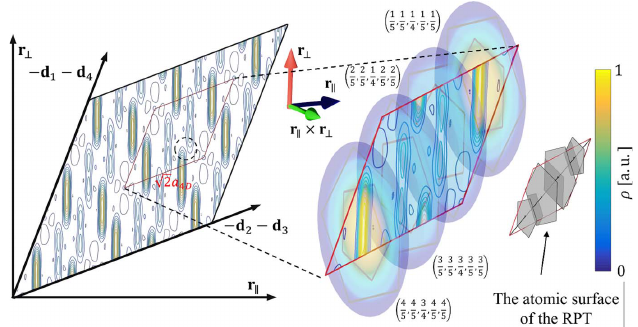
Figure 2 2D section through the 4D electron density map calculated on the basis of the 737 phased diffraction peaks. Two atomic layers of the physical space are superposed here. Four atomic surfaces centered along the [1111] direction are identified. They divide the long-body diagonal of the 4D unit cell into five equal sections. In the magnified picture of the section through one 4D unit cell, the distribution of the electron density within four atomic surfaces is emphasized. The smaller picture with four pentagons of the RPT is given as a guide. The maximal electron density is located in the first and fourth pentagons suggesting the distribution of TM atoms. The parameter a 4D is the edge-length of the 4D unit cell, which in the case of decagonite is equal to 5.478 A˚